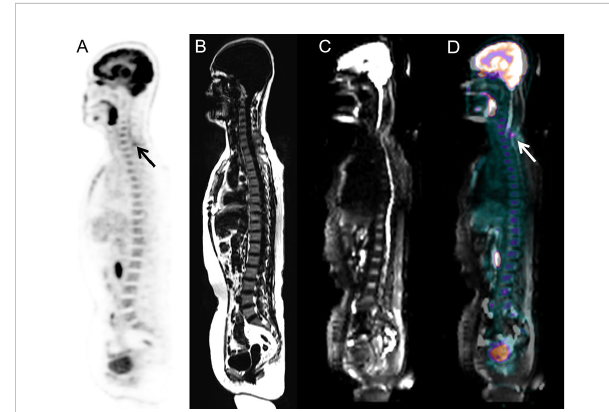
FIGURE 2 Images of a 58-year-old woman with low-grade follicular lymphoma. BMI was detected via PET/MRI according to the unifocal intense uptake of FDG on the PET image, while MRI did not show any intense signal because of artifacts. The presence of BMI was also con fi rmed through BMB. (A) PET image derived from integrated PET/MRI. (B) TIWI image derived from integrated PET/MRI. (C) DWI image derived from integrated PET/MRI. (D) Fused whole-body integrated PET/MRI.